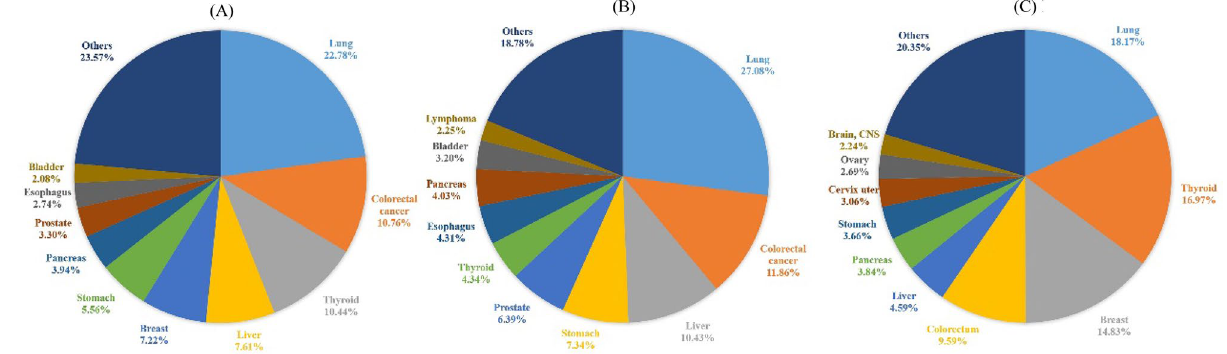
Figure 1. Distribution of cancer cases around Qinshan NPP from 2012 to 2020. ( A ) Both sexes, ( B ) males, and ( C ) females. For each sex, the area of the pie chart reflects the proportion of the total number of and colorectum, liver, stomach, prostate, thyroid, oesophagus, pancreas, bladder, and lymphoma, accounting for approximately four-fifths of all cancer cases. The corresponding cancers among women are lung, thyroid, breast, colorectum, liver, pancreas, stomach, cervix uterus, ovary, brain, and central nervous system cancers, accounting for nearly 80% of all cases (Table 10, Fig. 1). Incidence of radiosensitive cancer. From 2012 to 2020, a total of 258 new leukaemia cases were reported in the vicinity of the Qinshan NPP, accounting for 1.83% of all cases, with a crude incidence rate of 7.55/100,000, an ASIRC of 5.22/100,000, and an ASIRW of 5.46/100,000. The ASIRC of leukaemia was stable over the period (APC = − 1.4%, 95% CI − 5.4 to 2.7%). From 2010 to 2014, the ASIRC of leukaemia in Zhejiang Province was 5.26/100,000, in line with the present study 45 (Table 11). The results indicate that the normal operation of the Qinshan NPP has not yet caused an increase in the incidence of leukaemia for the population in the vicinity of the NPP. A total of 1469 new thyroid cancer cases were reported, accounting for 10.44% of all new cancer cases, with a crude incidence rate of 43.01/100,000, an ASIRC of 33.68/100,000, and an ASIRW of 29.17/100,000. The ASIRC in females (16.01/100,000) was 3.2 times as high as that in males (51.16/100,000) (Table 10). The ASIRC of thyroid cancer increased dramatically by 3.62-fold between 2012 and 2020, from 14.50/100,000 to 52.54/100,000. Over the period, the temporal trend of the ASIRC of thyroid cancer in both sexes in the vicinity of the Qinshan NPP increased by 16.3% per year (95% CI 9.5–23.5%). The ASIRC of thyroid cancer in this study is higher than that in a previous study in Zhejiang Province from 2010 to 2014 (24.11/100,000) 46 . This can be accounted for by the temporal trend of increasing thyroid cancer ASIRC both in Zhejiang Province 46 (APC = 28.62%, 95% CI 21.00–36.72%) and nationwide in China 47 (APC = 15.38%, 95% CI 13–16%). Many risk factors have been identified for thyroid carcinomas, such as ion- izing radiation, iodine intake, female hormones, and body mass index (BMI) 48 . From this study, the radiation doses and the corresponding excess risks were too low to account for the increased number of thyroid cancers in the vicinity of the Qinshan NPP. The reason why the incidence of thyroid cancer has been growing is likely to be related to the availability and improvement of thyroid gland imaging examination techniques, such as thyroid ultrasonography, which has been incorporated into medical checkups for residents throughout Zheji- ang Province, thus increasing the detection of thyroid cancer cases 46,48 . One of the possible other reasons is the